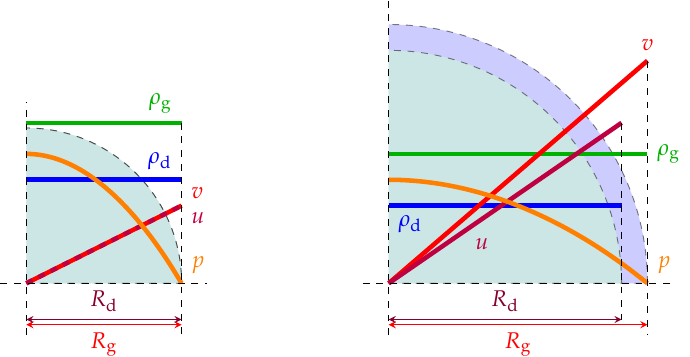
Figure 1. The sketch of spherically symmetric gas and dust cloud free expansion. The left and right panels show the distribution of macroscopic parameters for a gas and dust mixture at the initial time moment and at a given time,